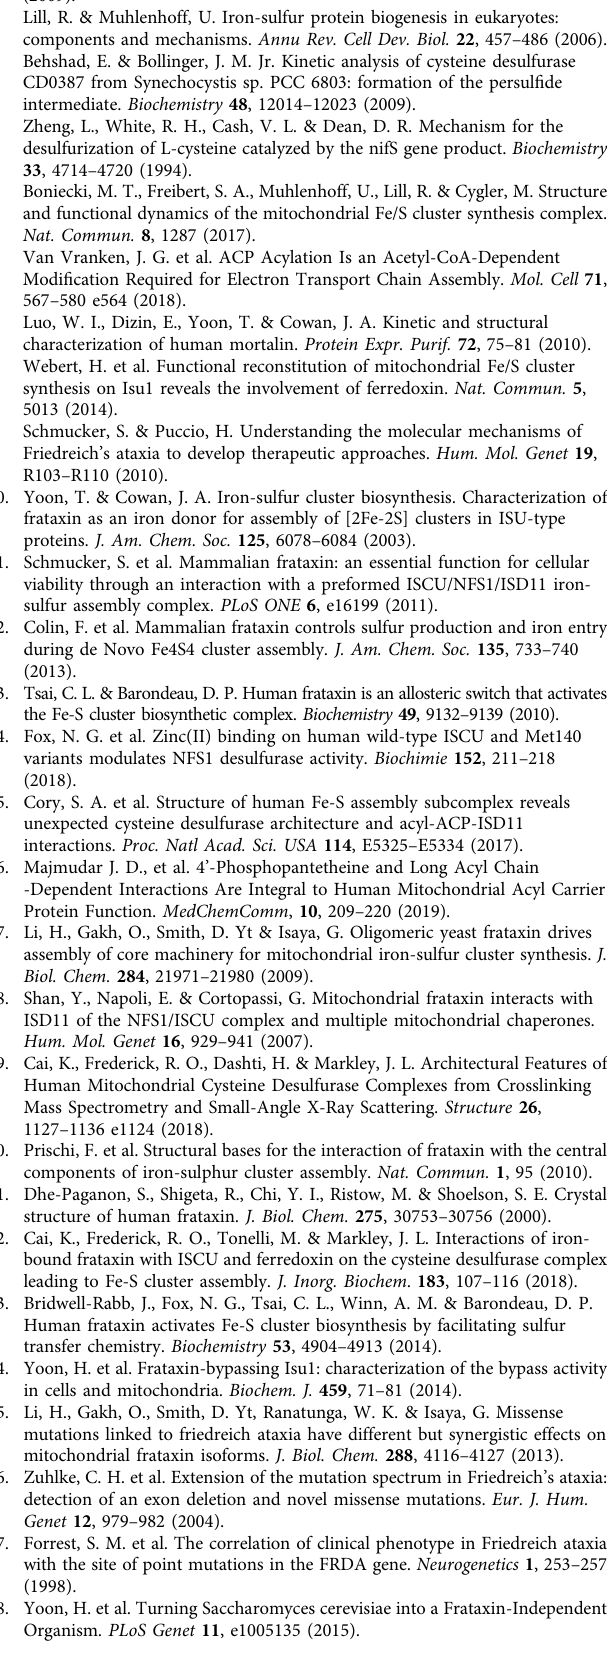
mentary Table 1. Model over fi tting was evaluated through its re fi nement against EM half maps. FSC curves were calculated between the resulting model and the working half map as well as between the resulting model and the free half and full maps for cross-validation (Supplementary Fig. 1). Figures were produced using PyMOL 49 and Chimera 44